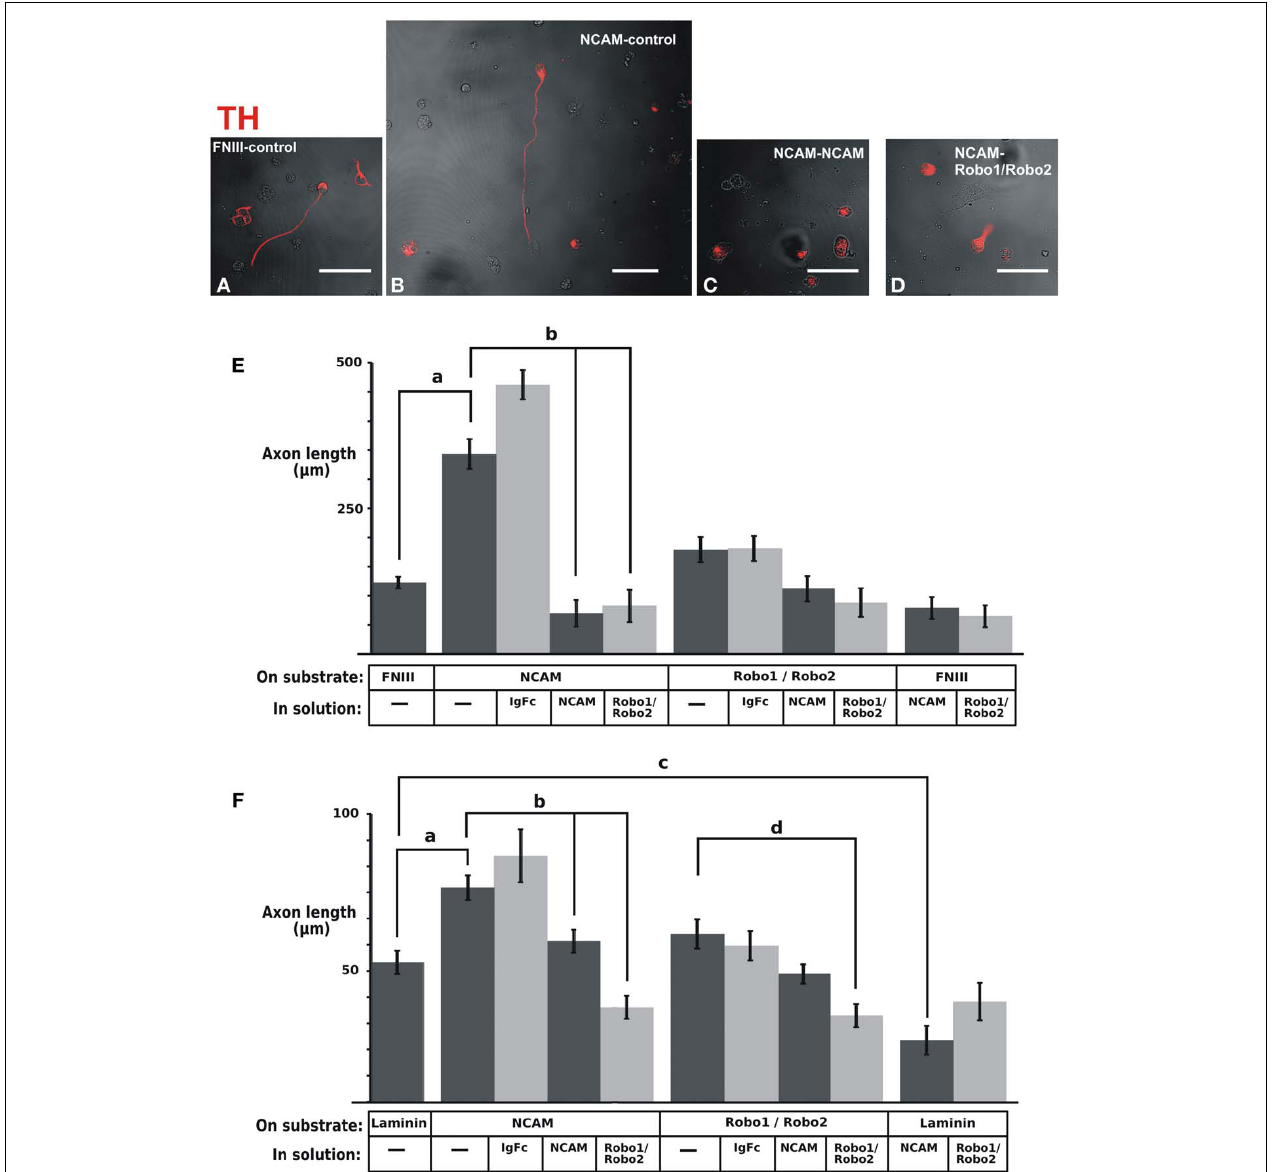
FIGURE 8 | NCAM on the substrate enhances dopaminergic axon growth in culture and soluble Robo1/Robo2 ectodomains block such effect. The ventral region of the midbrain containing dopaminergic neurons was extracted from E12 rat brains, dissociated and seeded onto coverslips coated with control substrates [fibronectin (FNIII) or laminin] or the ectodomains indicated. (A–D) Show examples of fluorescent TH immunostaining signal (red) overlaid on phase contrast images (b/w) of the same fields of some of the different culture conditions tested. The effect of soluble ectodomains was assessed by adding them to the culture medium as indicated. After culture, TH immunostaining was performed and the length of axons of individual